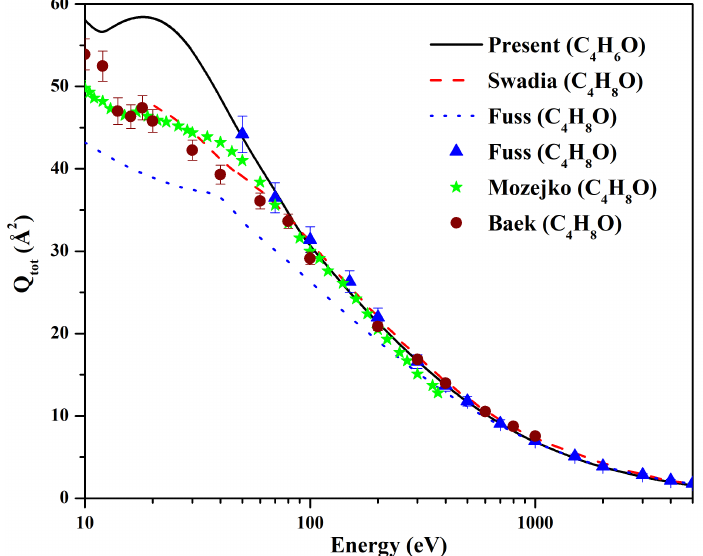
Figure 4. Q tot for furan, 2, 5-dihydro. Solid line: present Q tot ; dash line: Q tot for THF by Swadia et al. [13]; dotted line: Q tot for THF by Fuss et al. [18]; solid triangle: Q tot for THF by Fuss et al. [18]; solid star: Q tot for THF by Mozejko et al. [17]; solid circle: Q tot for THF by Baek et al.